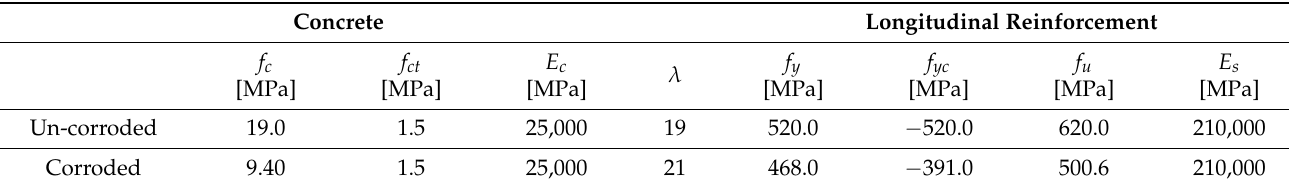
Table 1. Mechanical properties of columns adopted in